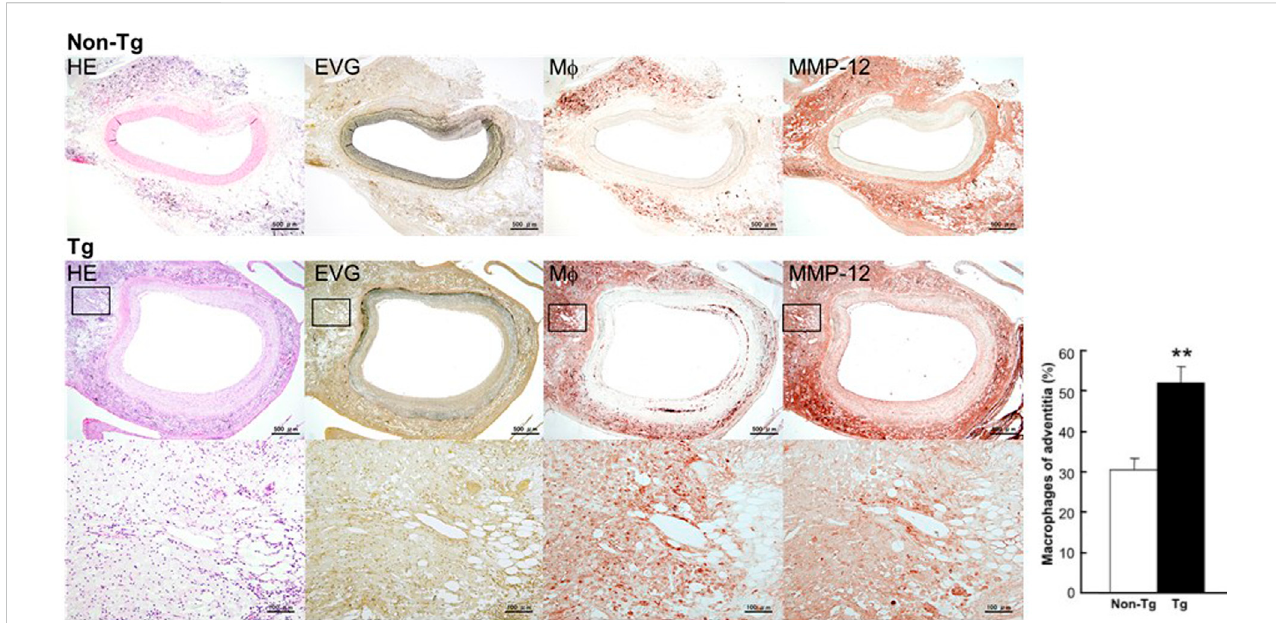
FIGURE 2 Micrographs of abdominal aortic lesions from non-Tg and Tg rabbits. Cross-sections were stained with H&E, with EVG, or immunohistochemically with Abs against macrophages and MMP-12. Adventitial macrophage in fi ltration and MMP-12 staining of a Tg rabbit aorta are shown at higher magni fi cation at the bottom. Macrophage in fi ltration was quantitated and showed as percentage. 4 – 10 immunostained sections from each rabbit ( n = 8 for non-Tg and 9 for Tg) were used. The data were expressed as the mean ± SE. ** p < .01 vs. non-Tg.